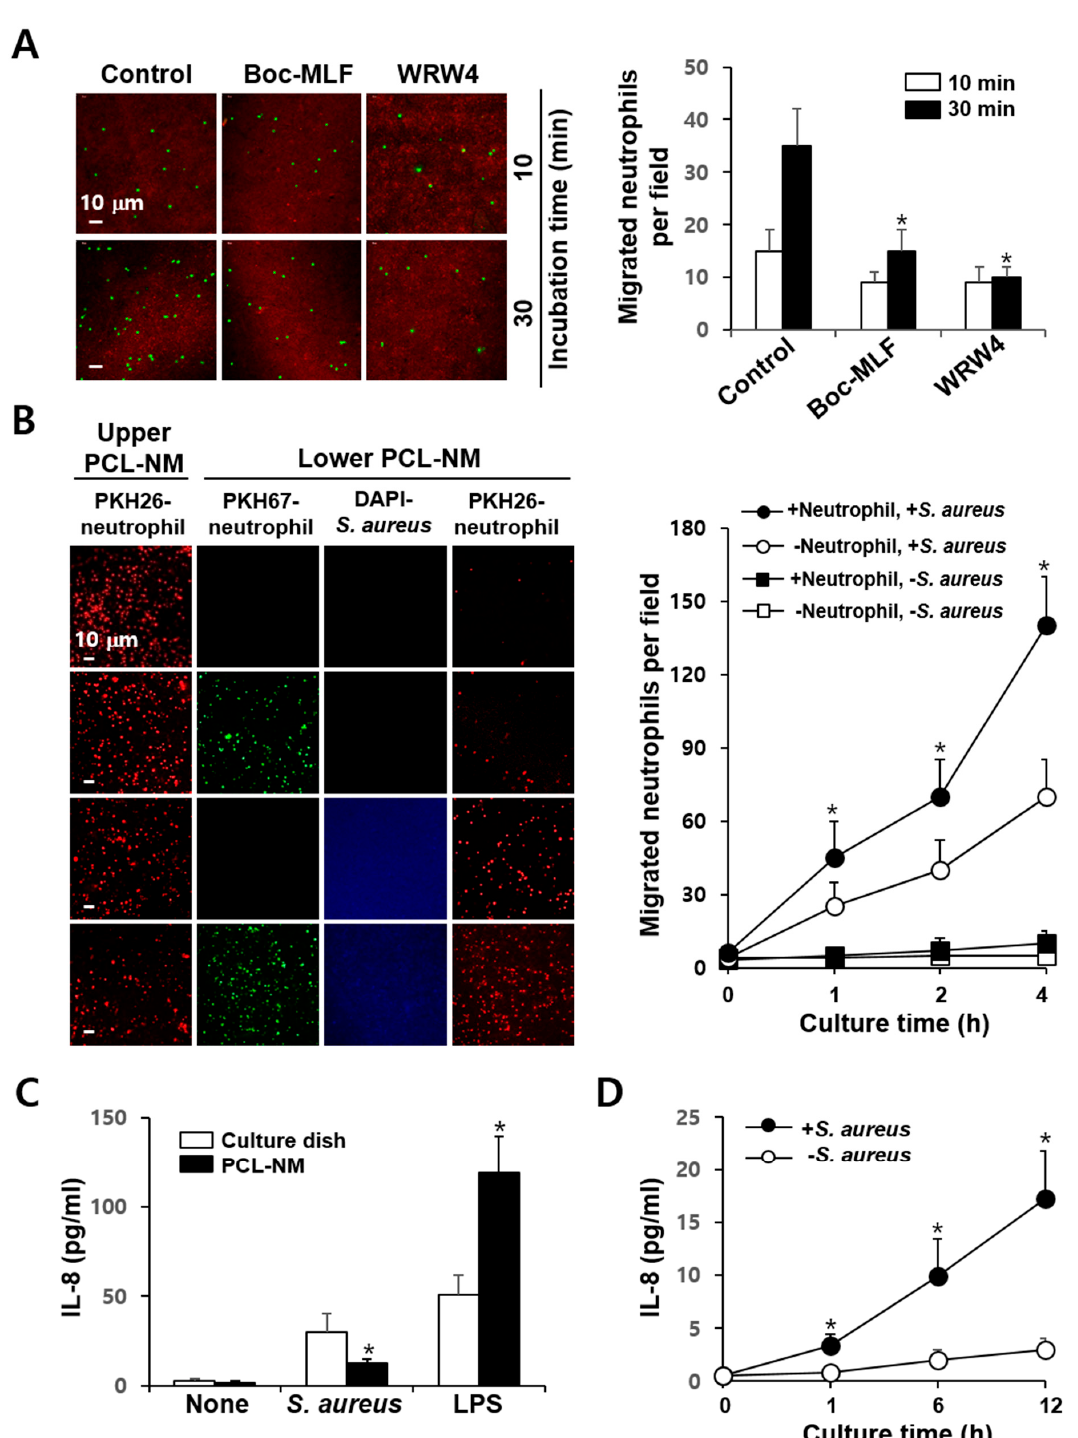
Figure 5. More neutrophils are recruited when S. aureus is cultured with neutrophils than when it is cultured alone. ( A ) PKH67-labeled BM-derived neutrophils (1 × 10 5 ) were top-seeded and pretreated with 0.1% DMSO (Control), Boc-MLF (20 µM) and WRW4 (4 µM) for 1 h in the upper PCL-NM. The migration rates of control and FRP inhibitor-pretreated neutrophils to the lower PCL-NM containing PKH26-labeled S. aureus (1 × 10 7 ) were measured for the indicated times in the presence of 0.1% DMSO (control), Boc-MLF (20 µM) and WRW4 (4 µM) ( n = 4). Green-fluorescent spots in the lower PCL-NM were counted. Asterisks (*) denote significant differences compared to the control ( p < 0.05). ( B ) PKH26-labeled neutrophils (1 × 10 5 ) in the upper PCL-NM were cultured with or without PKH67-labeled neutrophils (1 × 10 5 ) and/or